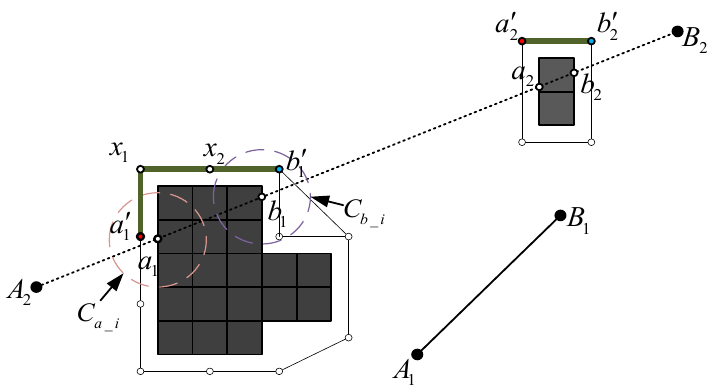
Figure 12. Schematic of the local feasible path in areas with dense obstacles.